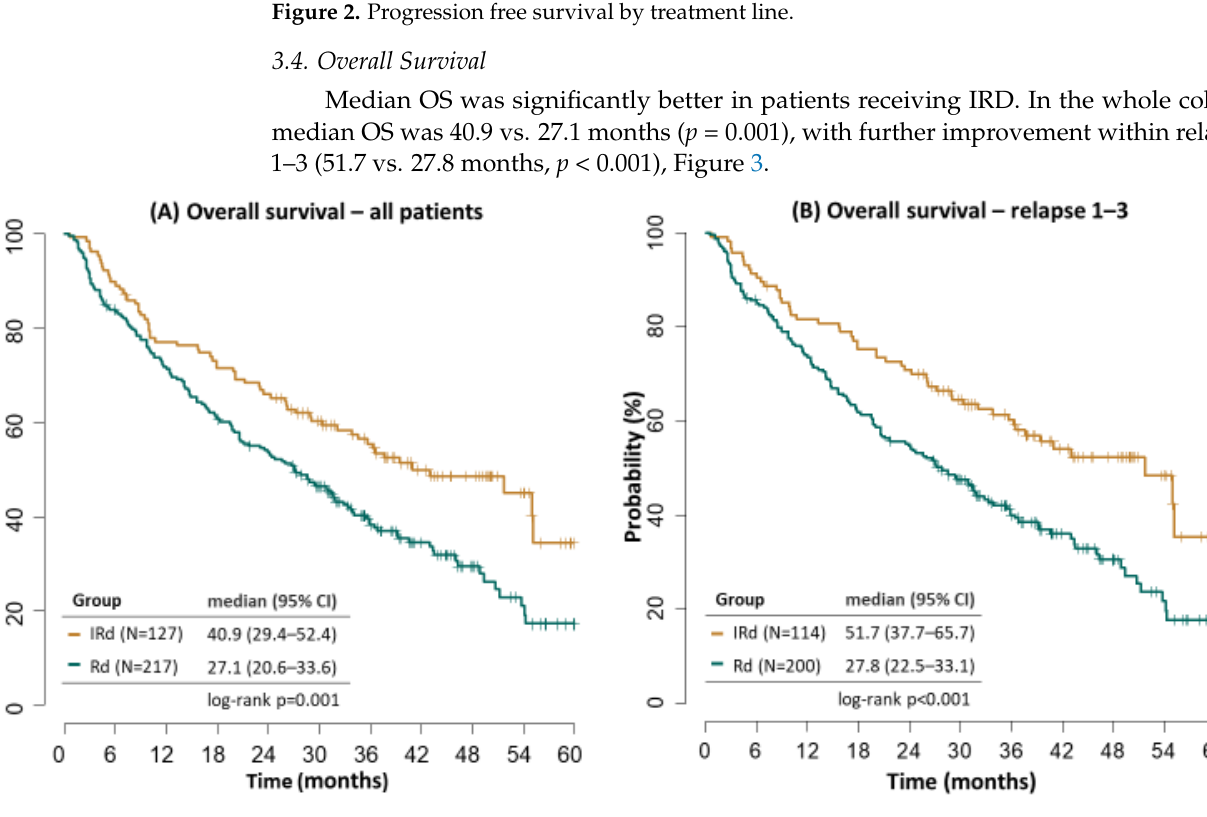
Figure 4. Overall survival by treatment line.